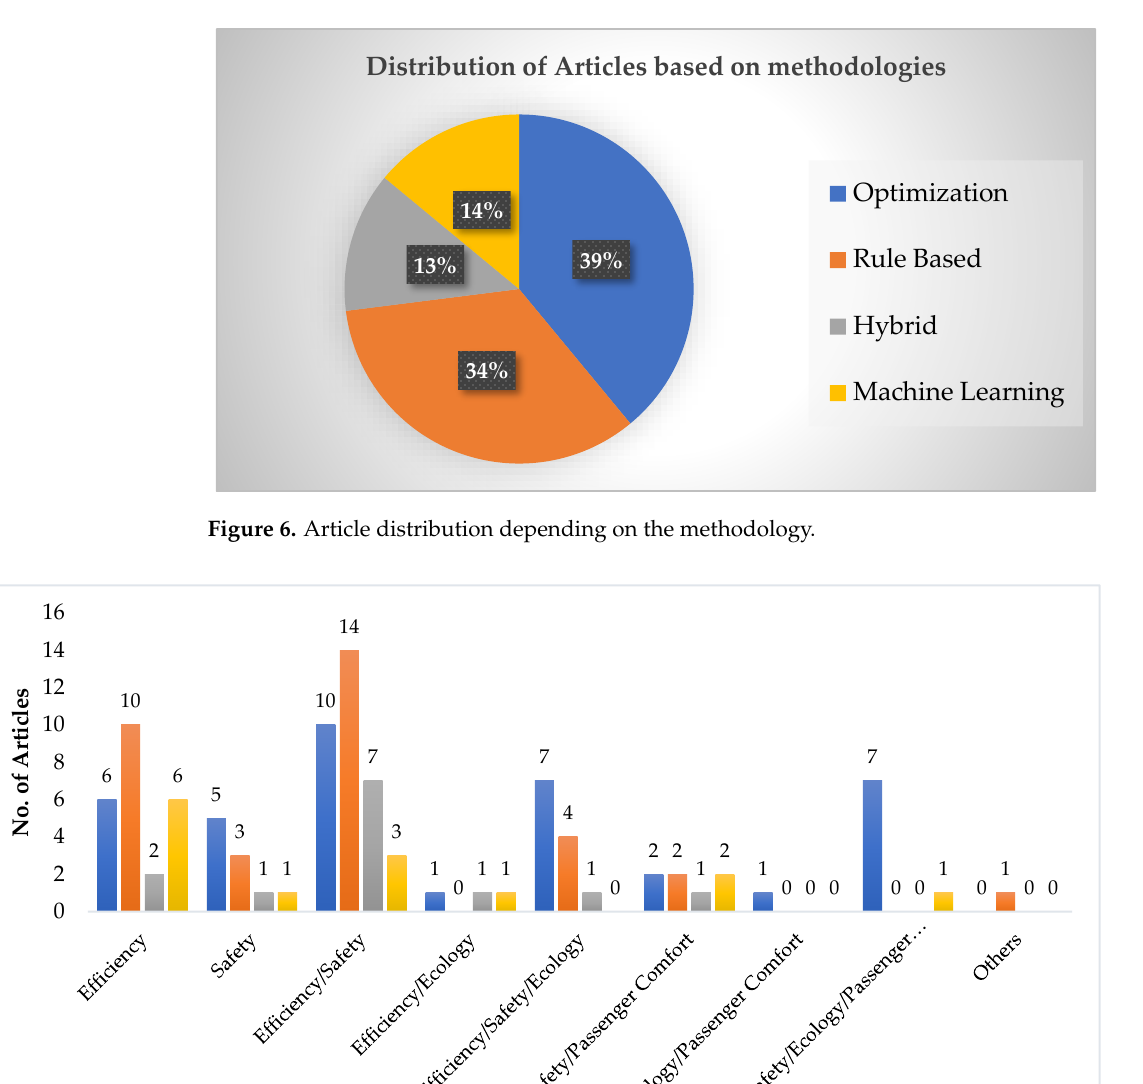
Figure 6. Article distribution depending on the methodology.